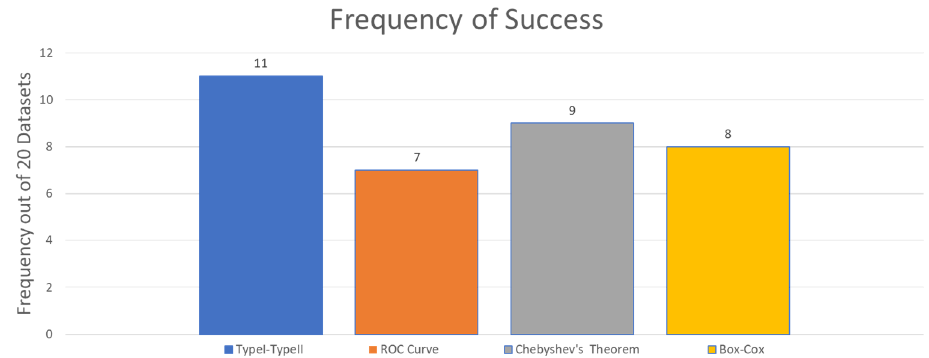
Figure 11. Frequency of successes over 20 datasets by all threshold methods.